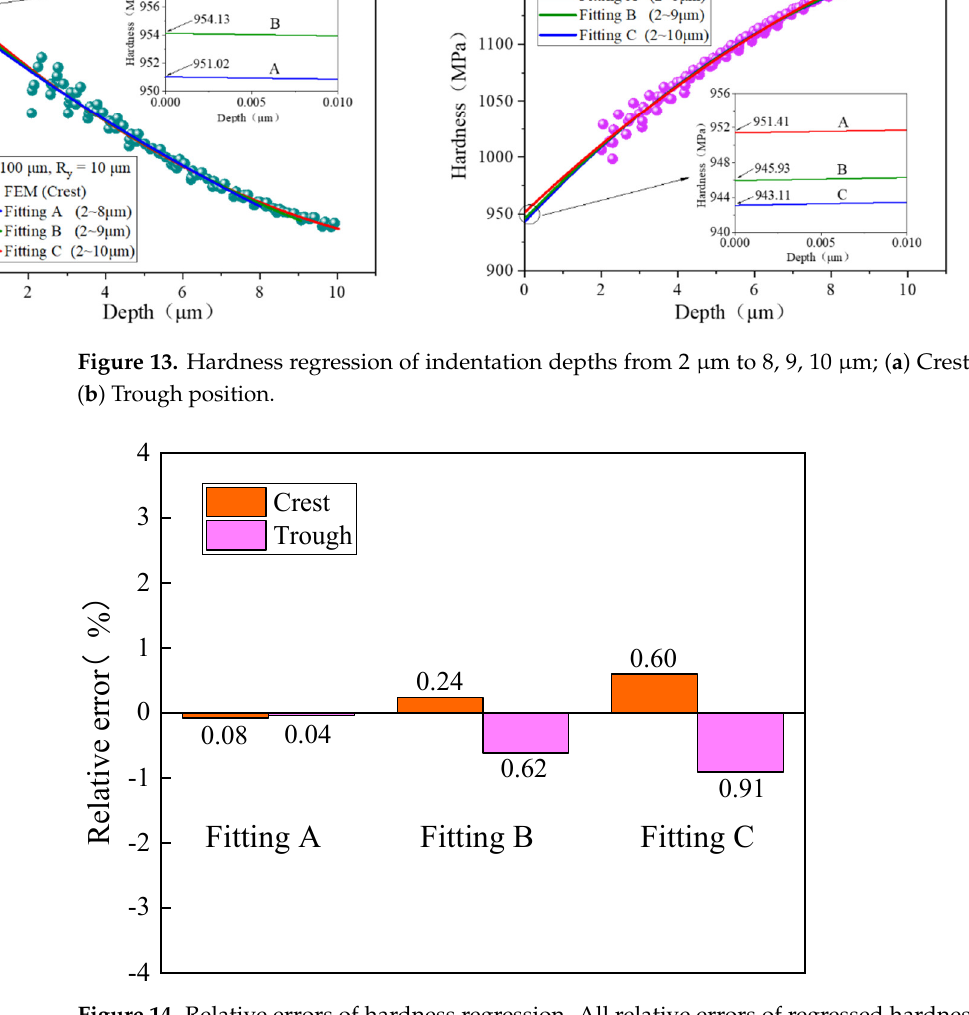
Figure 14. Relative errors of hardness regression. All relative errors of regressed hardness are less than 1%.